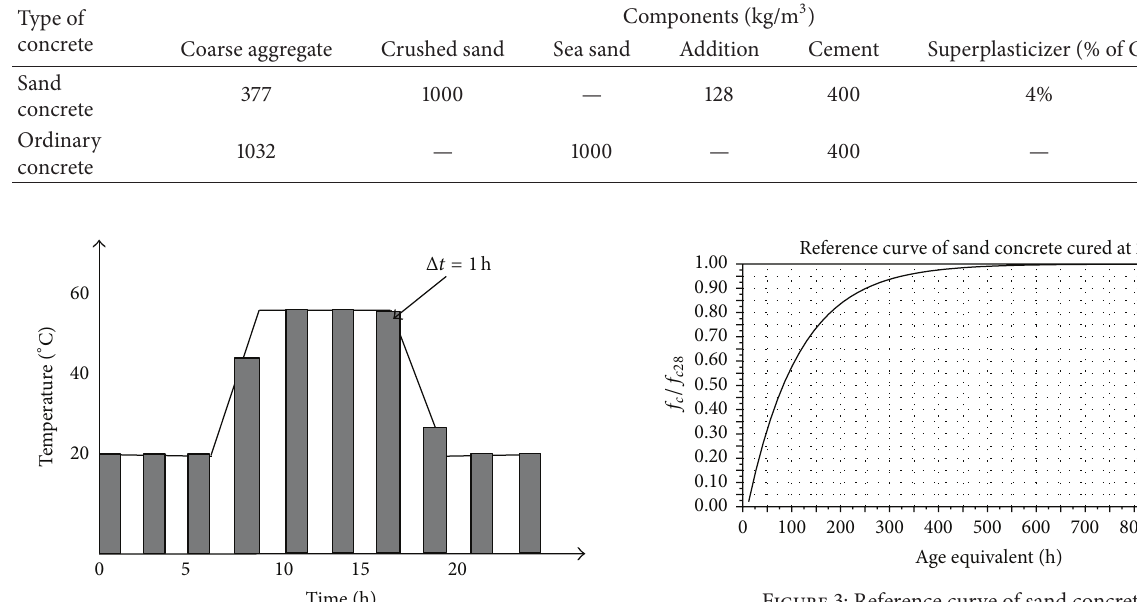
Figure 3: Reference curve of sand concrete.